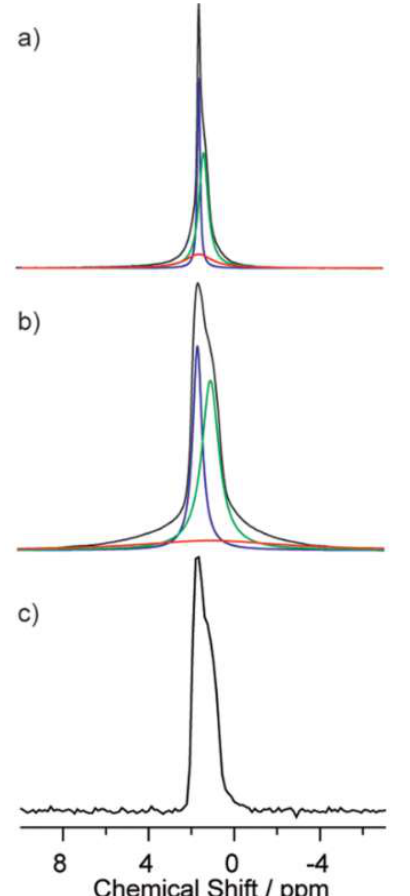
Figure 10. 7 Li MAS NMR spectra of 70 gc at ( a ) 360 K and( b ) 270 K. ( c ) 6 Li MAS NMR spectrum of 70 gc at room temperature. [36]